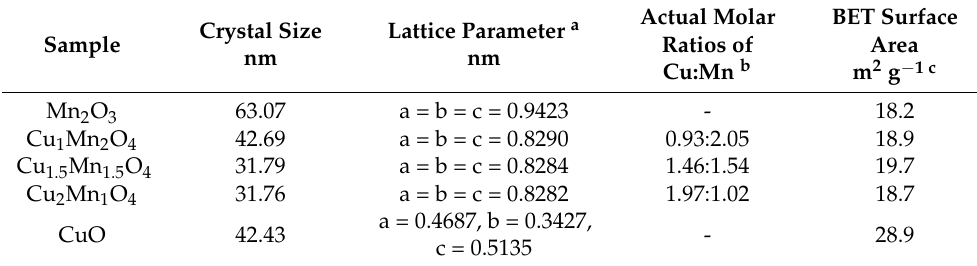
Figure 1. XRD patterns ( a ), local enlargement of (I) in XRD ( b ) of the as-synthesized Cu x Mn 3 − x O 4 samples. Table 1. Crystal sizes, lattice parameters, actual molar ratios of Cu to Mn and BET surface areas of Cu x Mn 3 − x O 4